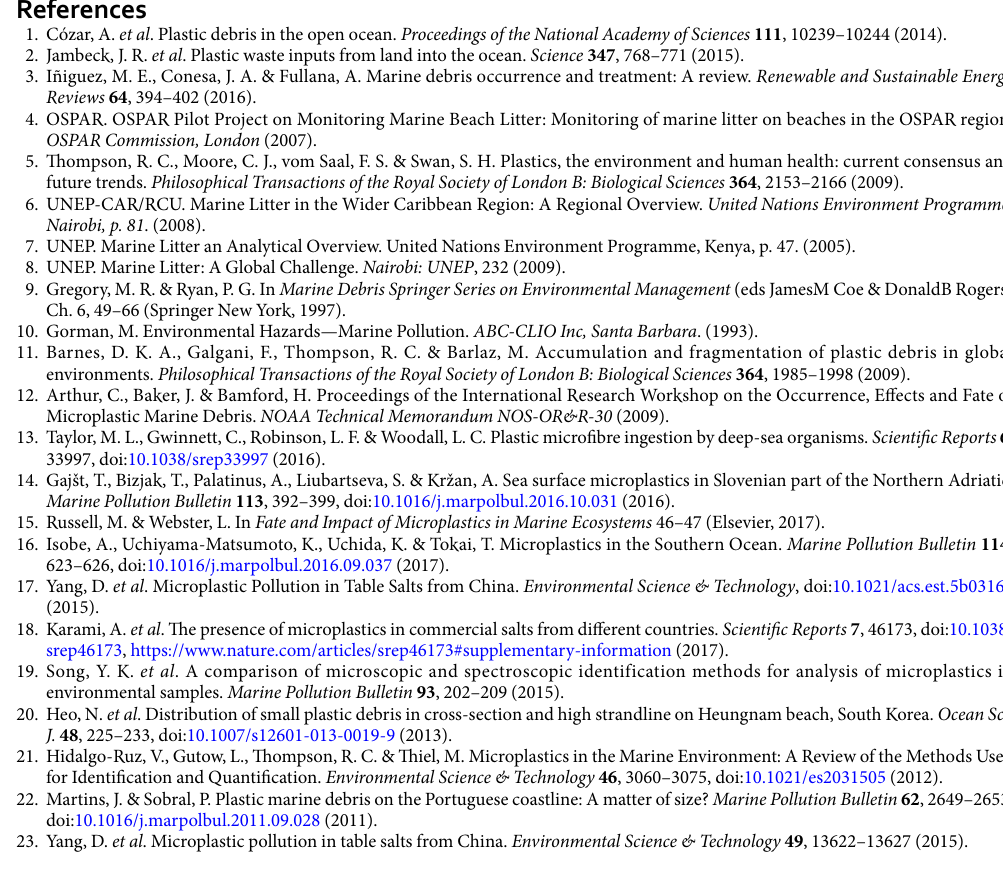
obtained were compared to the library to identify the polymer type (NICODOM IR Libraries). The spectrum analysis followed the method of Woodall et al . 28 . Data Availability. The datasets generated during and/or analyzed during the current study are available from the corresponding author on reasonable request.